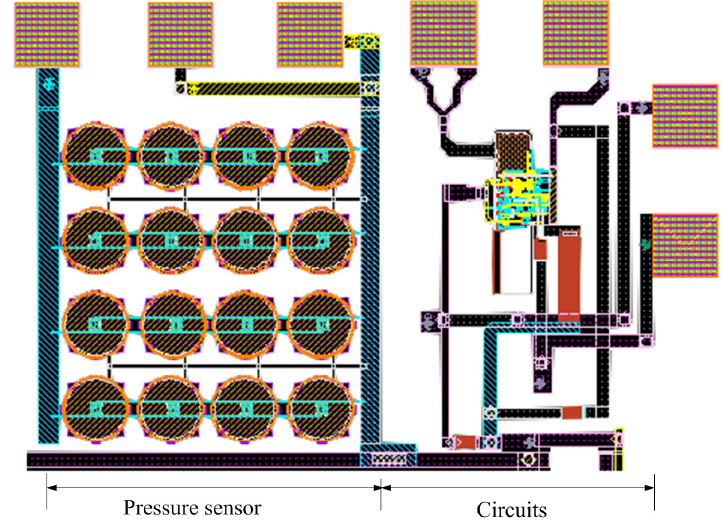
Figure 1. Layout of the FET pressure sensor with circuits.